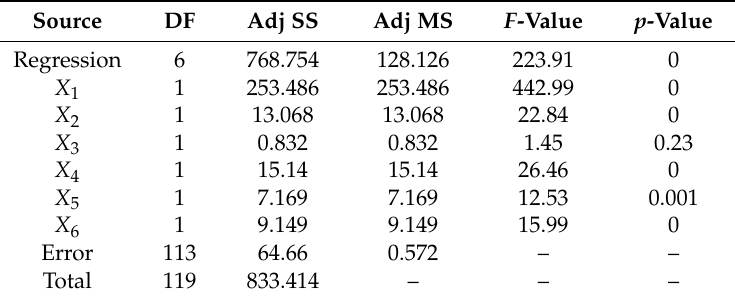
Table 11. Analysis of